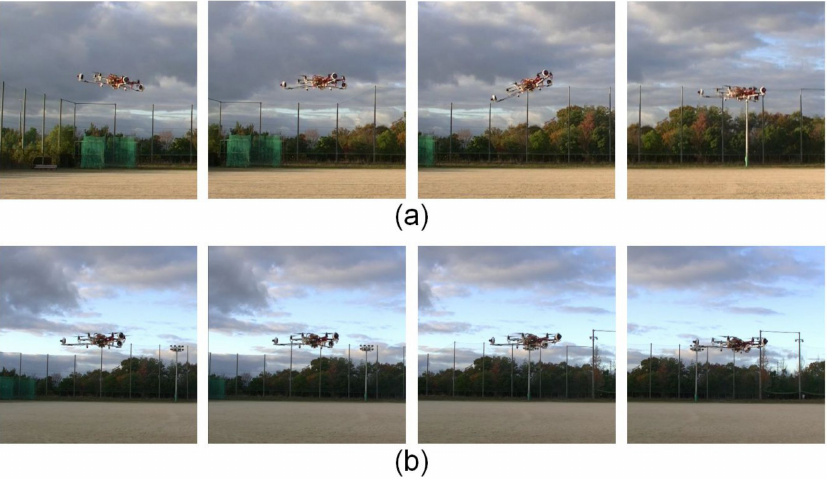
Figure 8. Continuous images of the brake-like motion in different control mode: ( a ) the multirotor control mode; and ( b ) ATD control mode. Both ( a , b ) follow from left to right, and they correspond to Seconds 7–9 in Figure 7. The video of the experiment is available from the supplementary